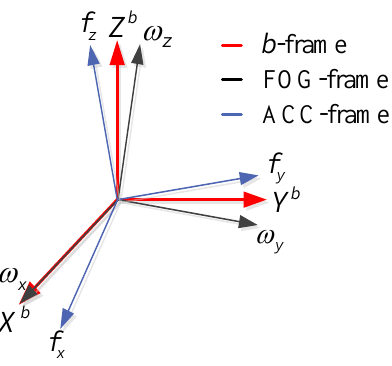
Figure 3. The relationship between different frames. Therefore, the matrix δ k g could be represented as (11) while the matrix δ k a remains still.